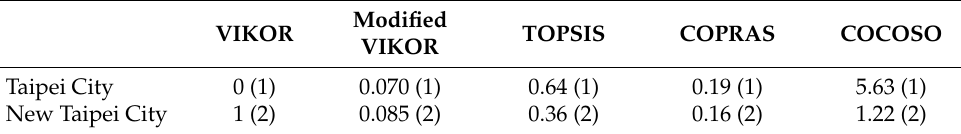
Table 9. Comparison with other